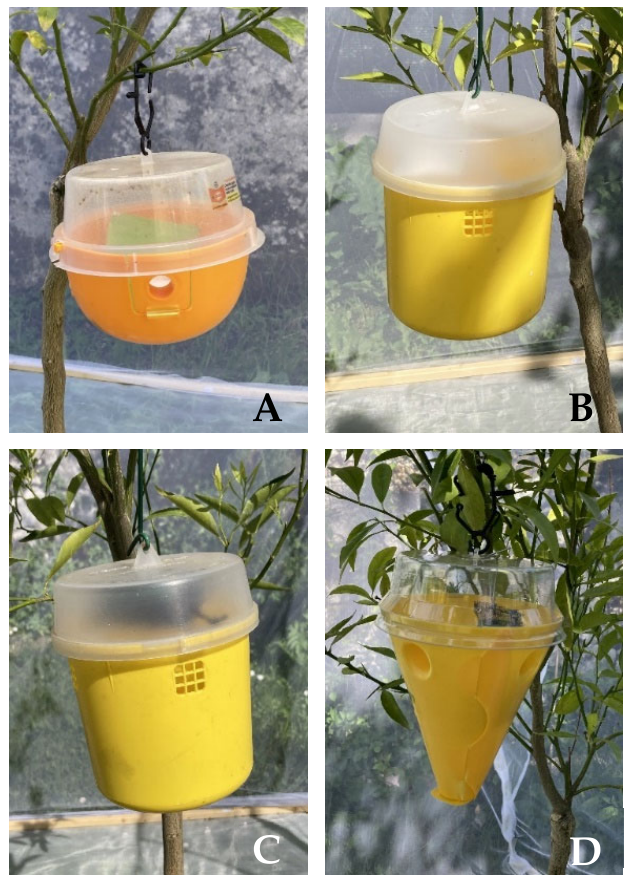
Figure 1. Medfly trapping systems used for the experimentation: Decis Trap ( A ), Tephri Trap Ecological baited with Trypack ( B ), Tephri Trap Ecological baited with Biodelear ( C ), Conetrap baited with Biodelear ( D ).